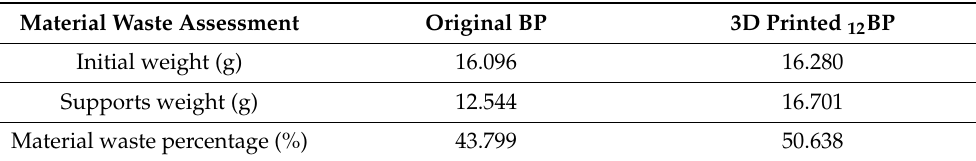
Table 1. Weight of 3D-printed tablets and relative supports produced using the original BP and the 3D-printed 12 BP. Measurements were taken before and after supports were removed from tablets ( n = 10). Material waste percentage is expressed as the ratio of support weight over initial weight.